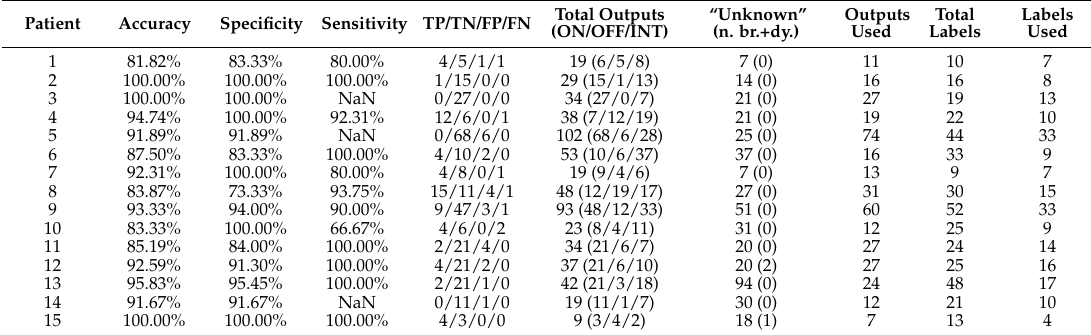
Table 5. Results organised by patient. The number of outputs given by the sensor and algorithm are presented in the ‘Total outputs’ column, distinguishing among ON, OFF and INT states. The number of Unknown outputs is shown as “Unknown”, being in brackets the amount corresponding to a detection of both bradykinesia and dyskinesia “(n. br. + dy.)”. Patient Accuracy Specificity Sensitivity TP/TN/FP/FN Total Outputs (ON/OFF/INT) “Unknown” (n. br.+dy.) Outputs